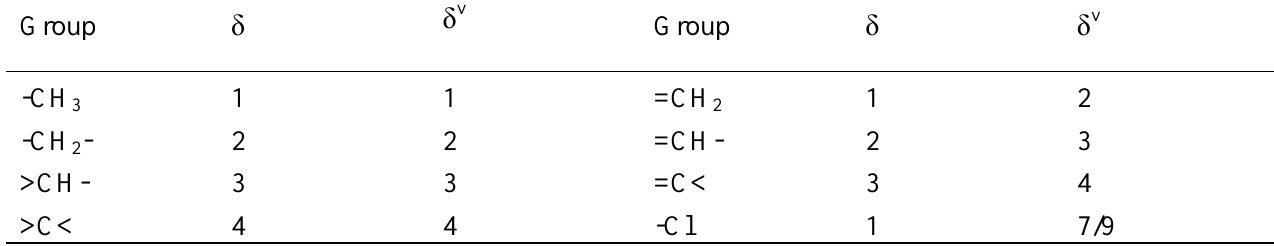
Table 1. Connectivity Index ( δ and δ v ) values of groups used in this